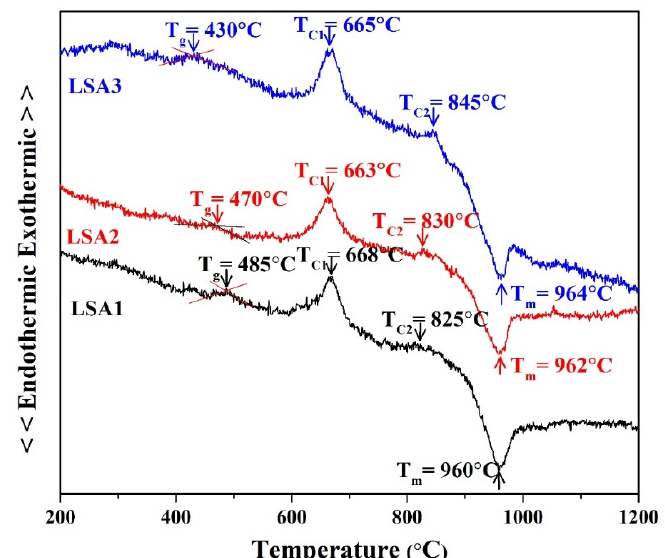
Figure 1. DTA curves of Li-Si glass powder with different Al 2 O 3 contents.